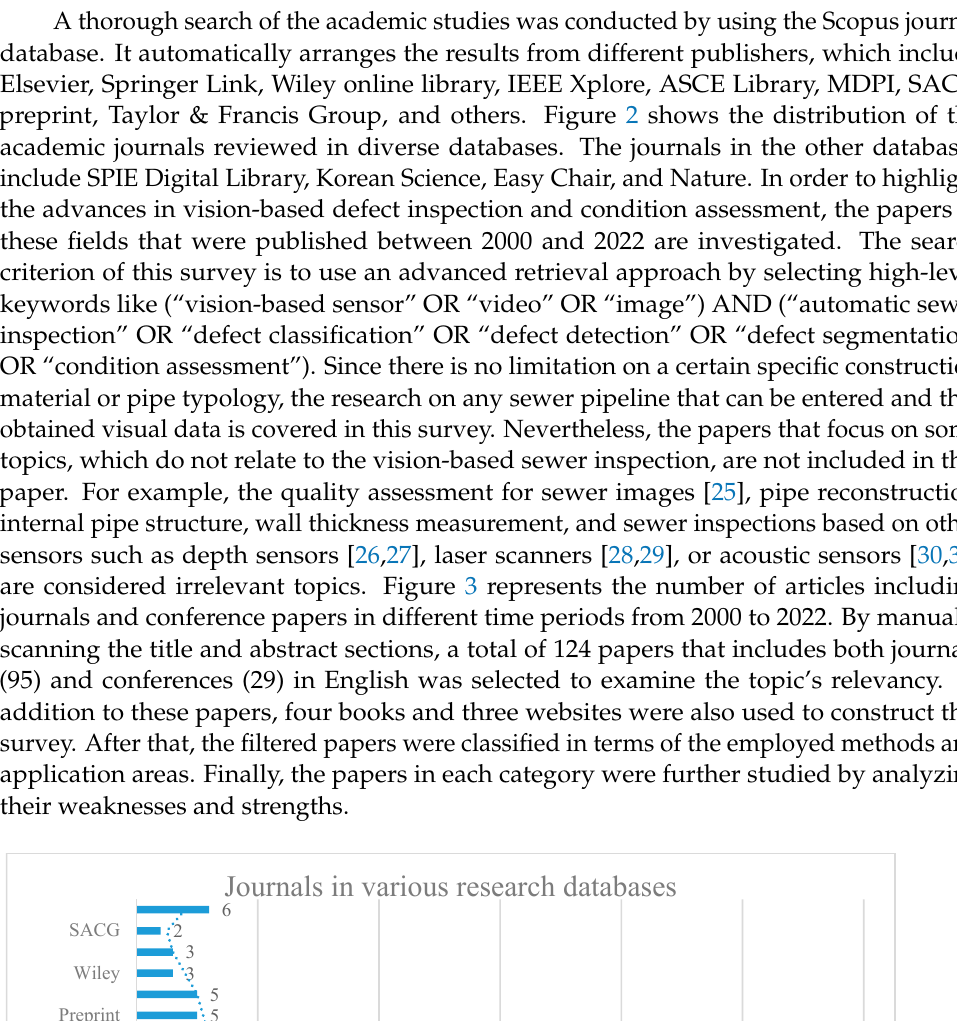
Figure 3. Number of publications investigated in different time periods (from 2000 to 2022). 3. Defect Inspection In this section, several classic algorithms are illustrated, and the research tendency is analyzed. Figure 4 provides a brief description of the algorithms in each category. Ac- cording to the literature review, the existing studies about sewer inspection are summa- rized in three tables. Tables 2–4 show the recent studies about defect classification (Sec- tion 3.1), detection (Section 3.2), and segmentation (Section 3.3) algorithms. In order to comprehensively analyze these studies, the publication time, title, utilized methodology, advantages, and disadvantages for each study are covered. Moreover, the specific pro- portion of each inspection algorithm is computed in Figure 5. It is clear that the defect classification accounts for the most significant percentages in all the investigated studies.